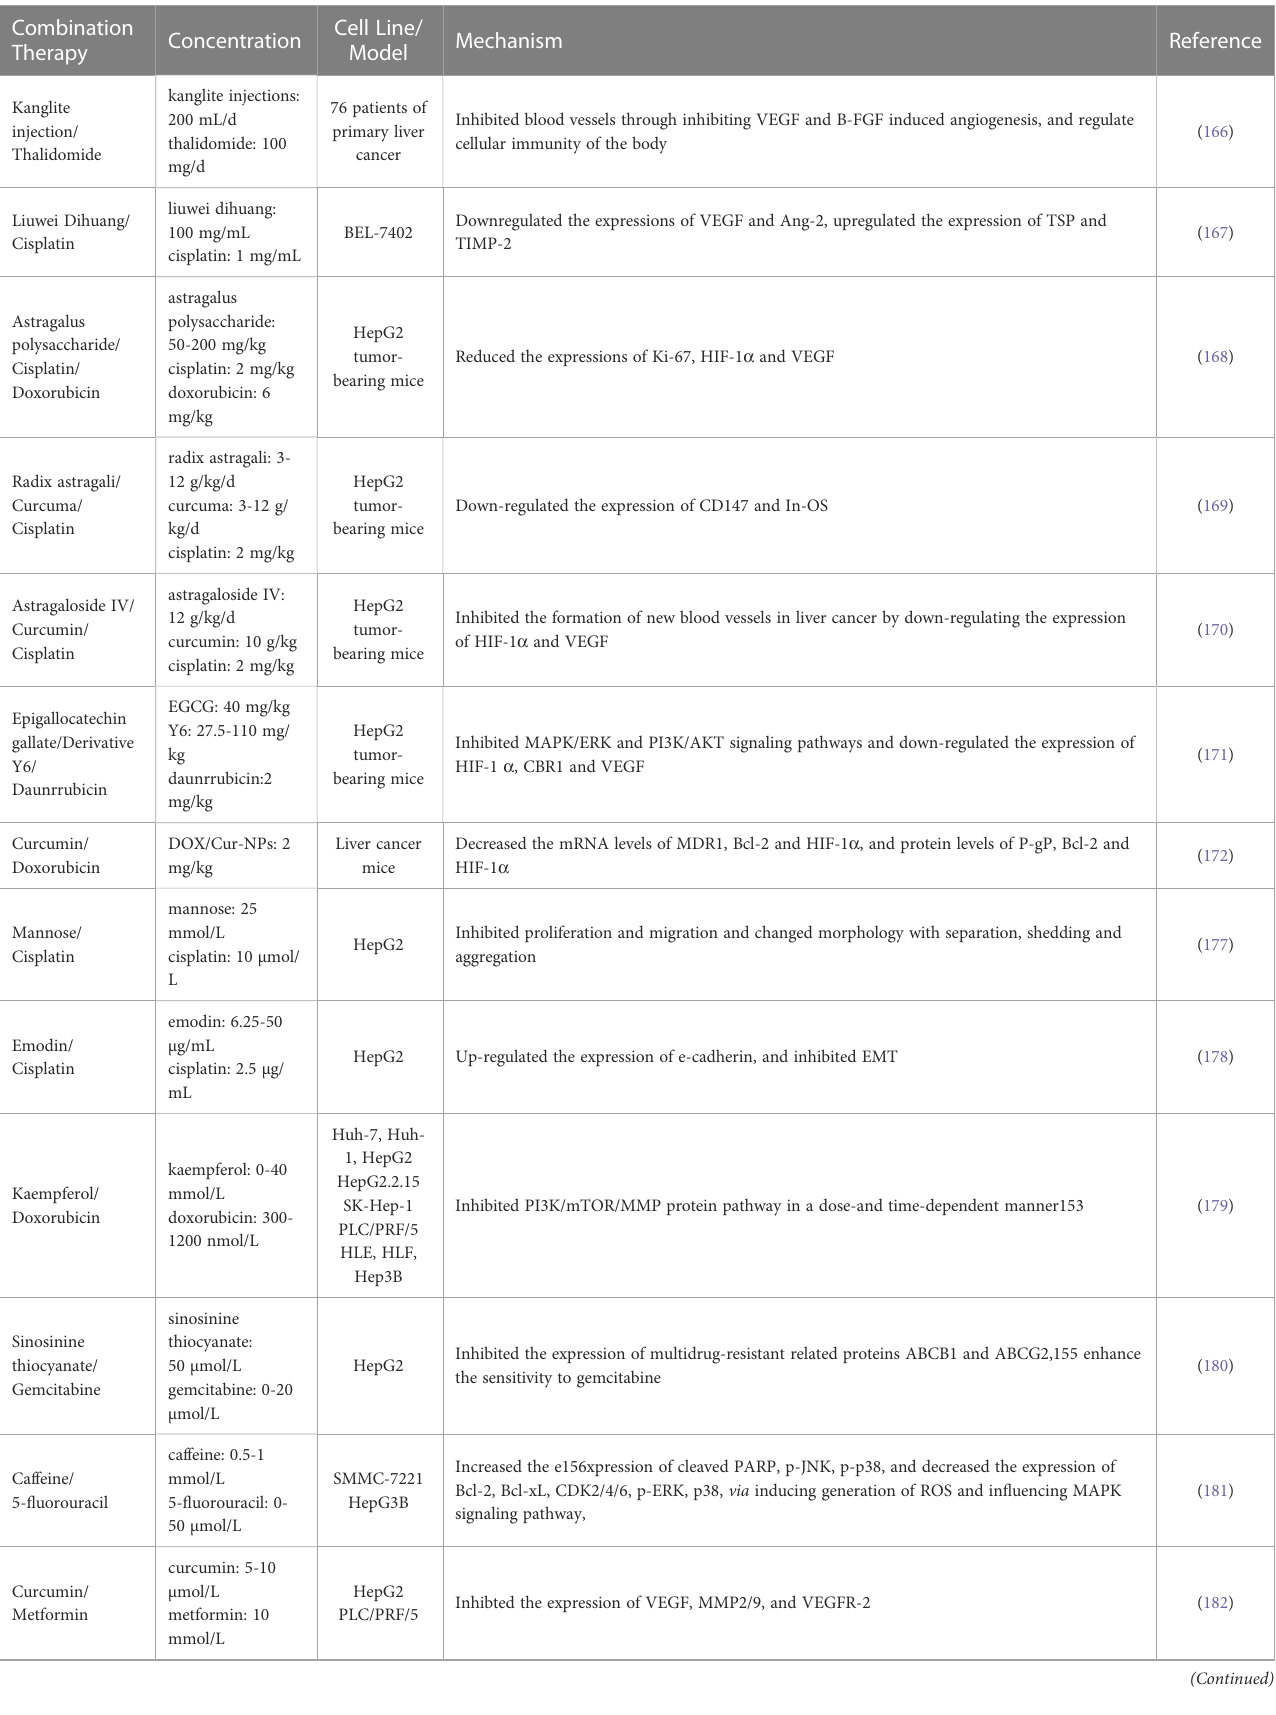
TABLE 2 Effect and mechanism of plant-derived natural products combination Chemotherapy drugs. Combination